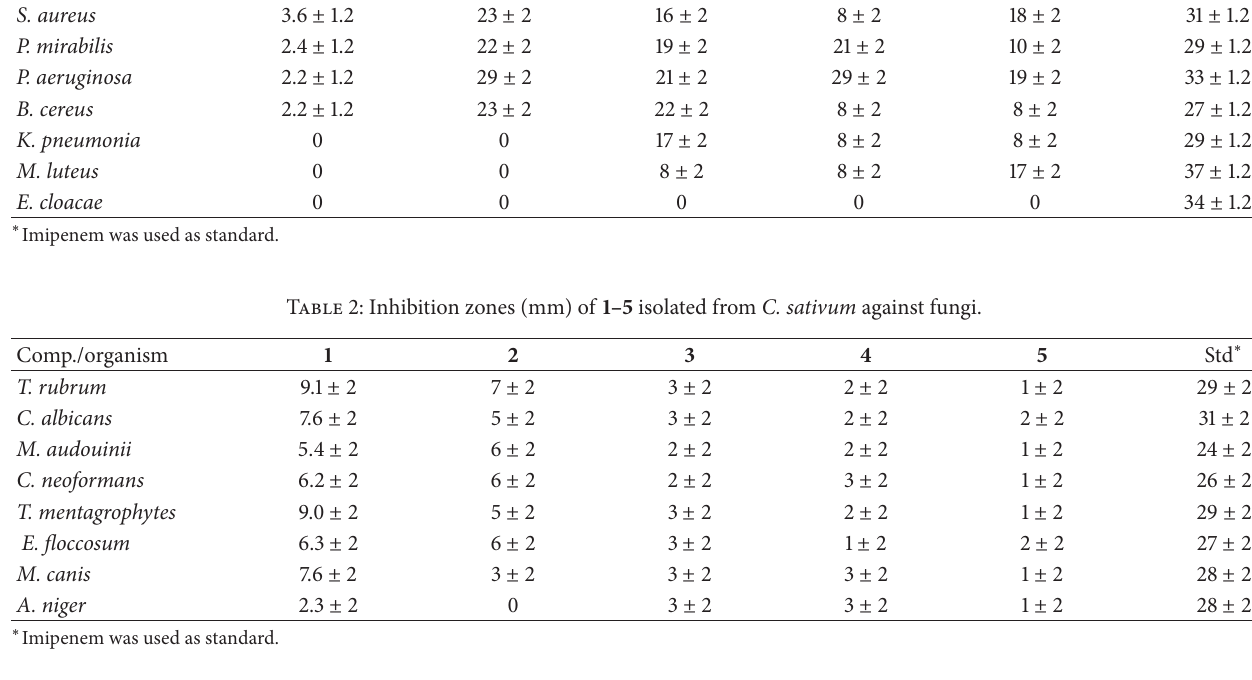
Imipenem was used as standard.